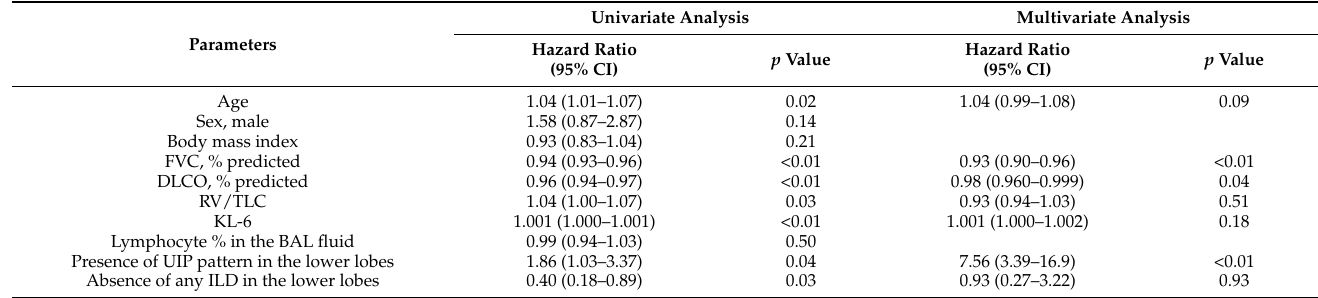
Table 3. Cox proportional hazards model assessment of potential predictors of mortality in patients with idiopathic PPFE.